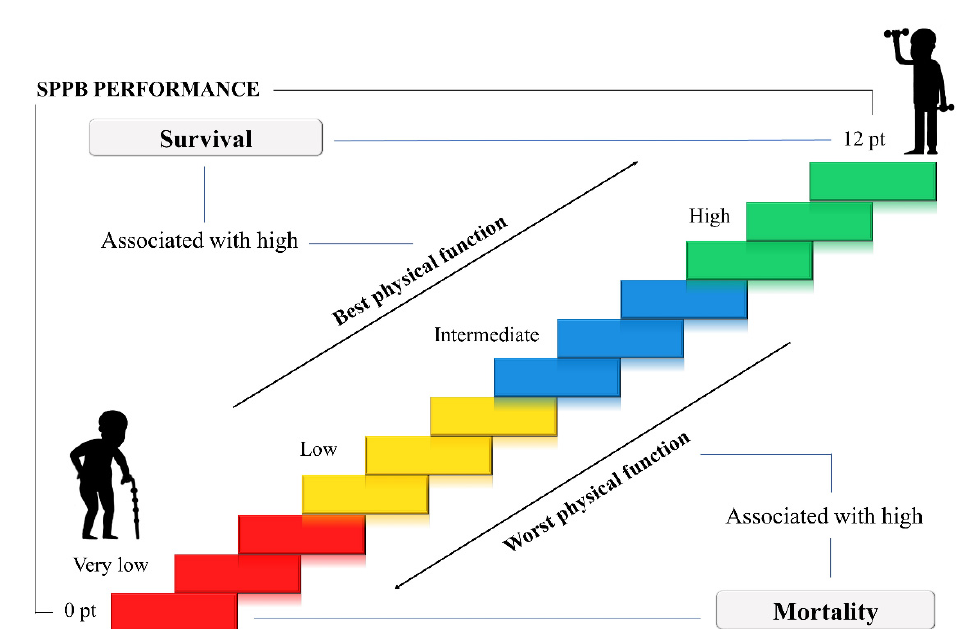
Figure 3. Association of mortality and survival according to SPPB categories (very low 0–3, low 4–6, intermediate 7–9, high 10–12).